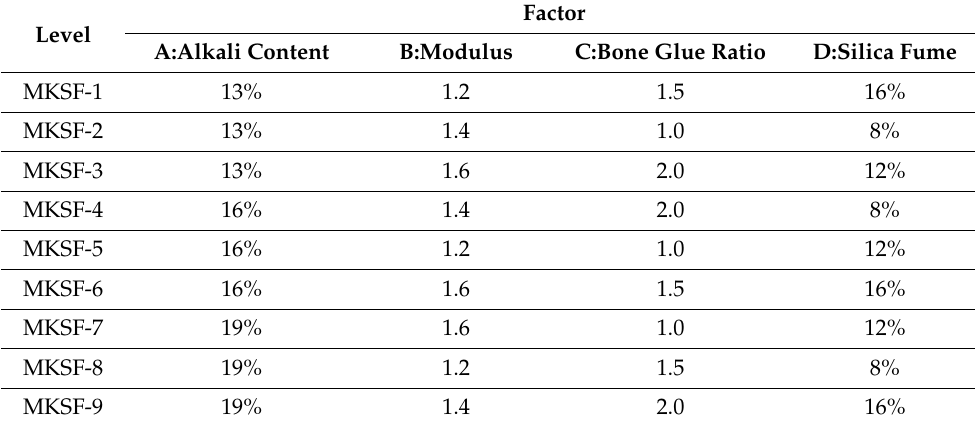
Table 5. Orthogonal experimental table of four factors and three